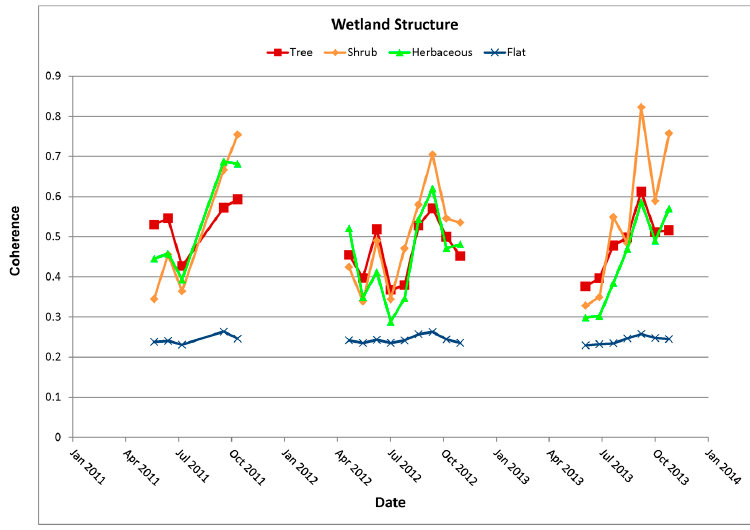
Figure 3. Coherence as a function of time for four structural classes.